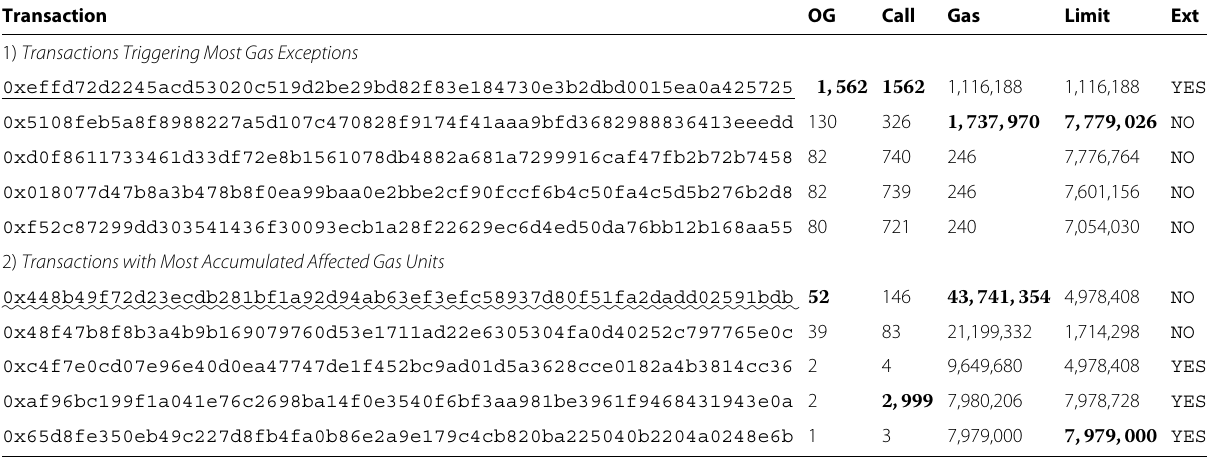
Table 4 A list of top 5 external transactions that: 1) triggering the most out of gas exceptions; as well as 2) with the most accumulated wasted gas Transaction